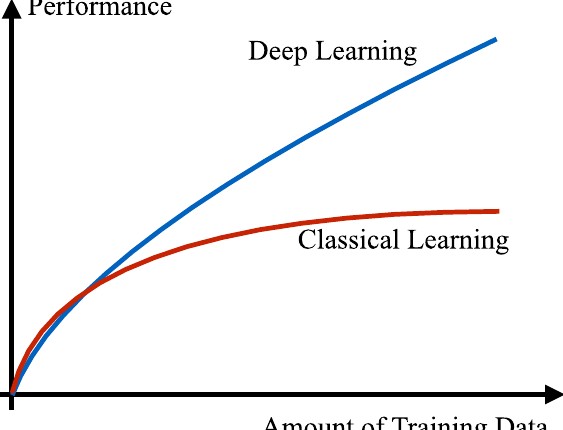
Figure 17. The major progresses in the field of artificial intelligence AI [95].